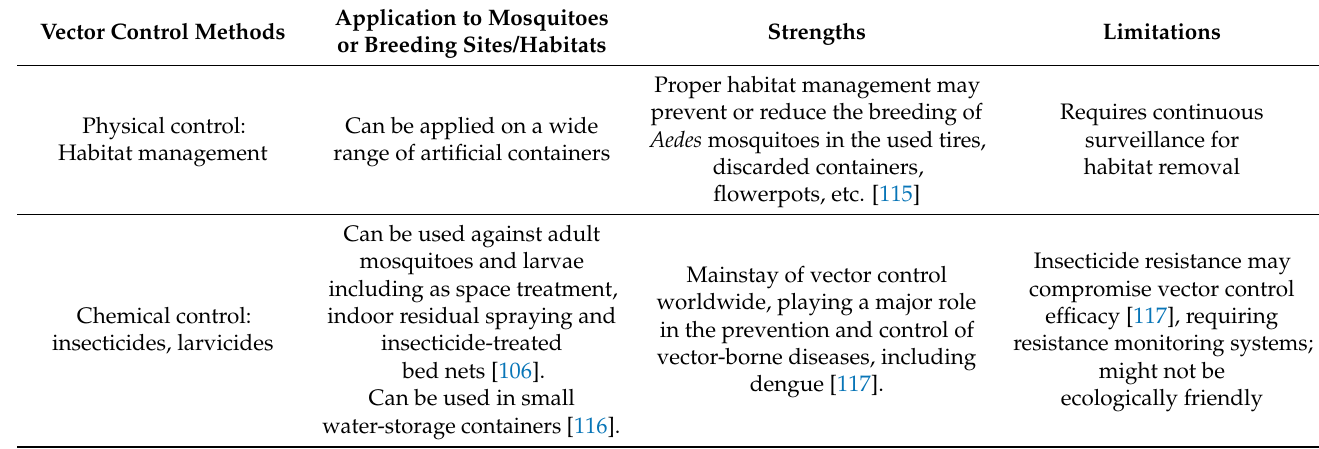
Table 1. Comparison of different major vector control strategies targeting Aedes aegypti and Aedes